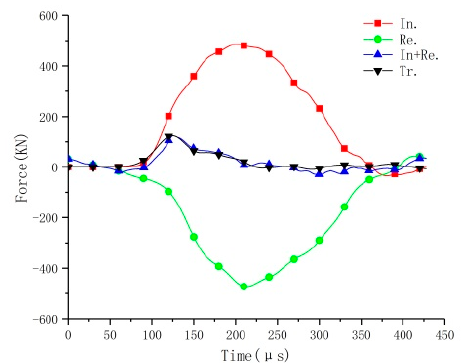
Figure 4. Dynamic force balance (In: Incident wave, Re: Reflected wave, Tr: Transmitted wave).